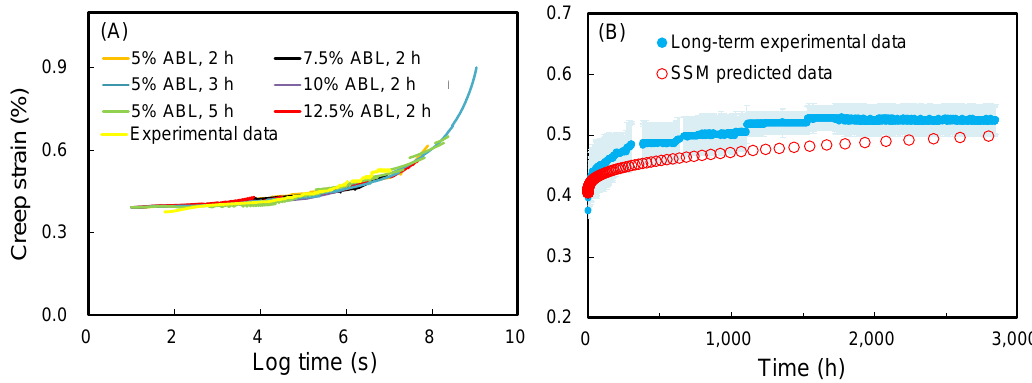
Figure 2. ( A ) Master curves of WIC MTEOS from different SSM testing parameters at a logarithmic time scale. ( B ) SSM-predicted creep curve and experimental creep data of WIC MTEOS at a normal time scale. Experimental creep data are displayed as the mean (blue line) ± SD (light blue ribbon) ( n = 3).